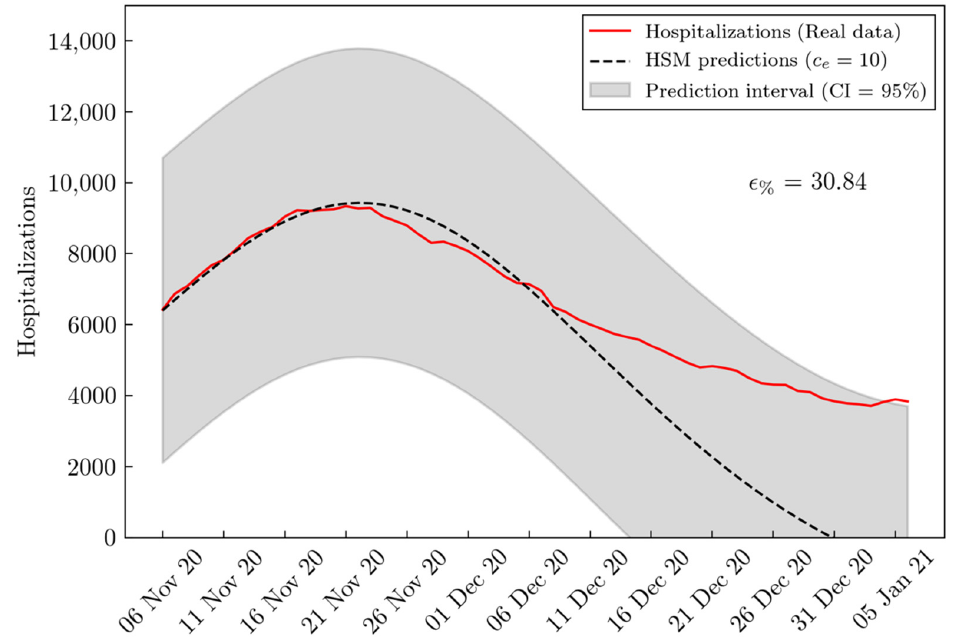
Figure 7. Real vs predicted hospitalizations in Lombardy. HSM predictions (dashed black line) for the average contact rate c e = 10 and real hospitalizations in Lombardy (straight red line) from 6 November 2020 to 6 January 2021 are reported. The 95% prediction confidence interval along with the average percentage error ( 𝜖 % ) between HSM hospitalization predictions and actual hospitaliza- tions data are also reported.